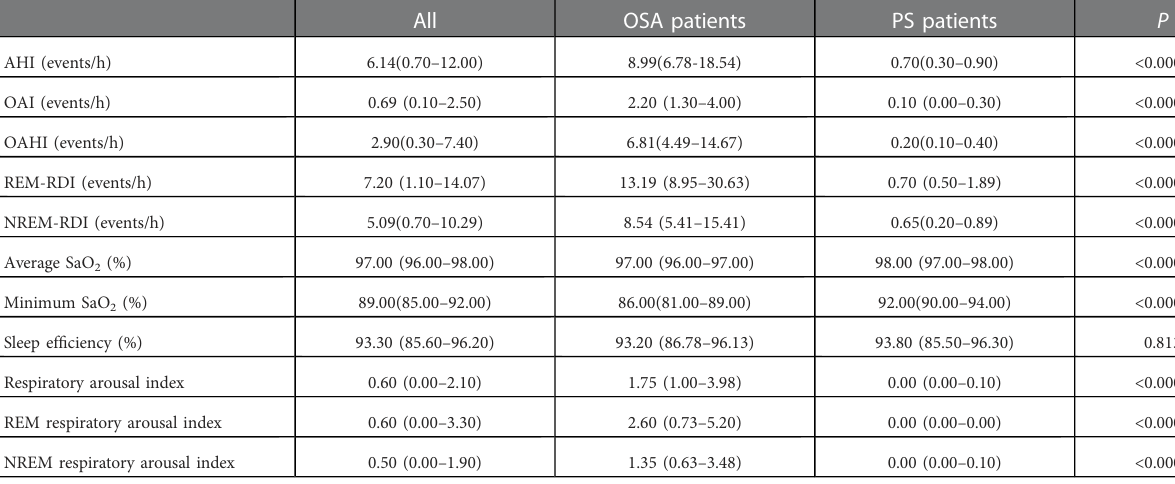
TABLE 2 Comparisons of PSG characteristics of the OSA and PS patients.